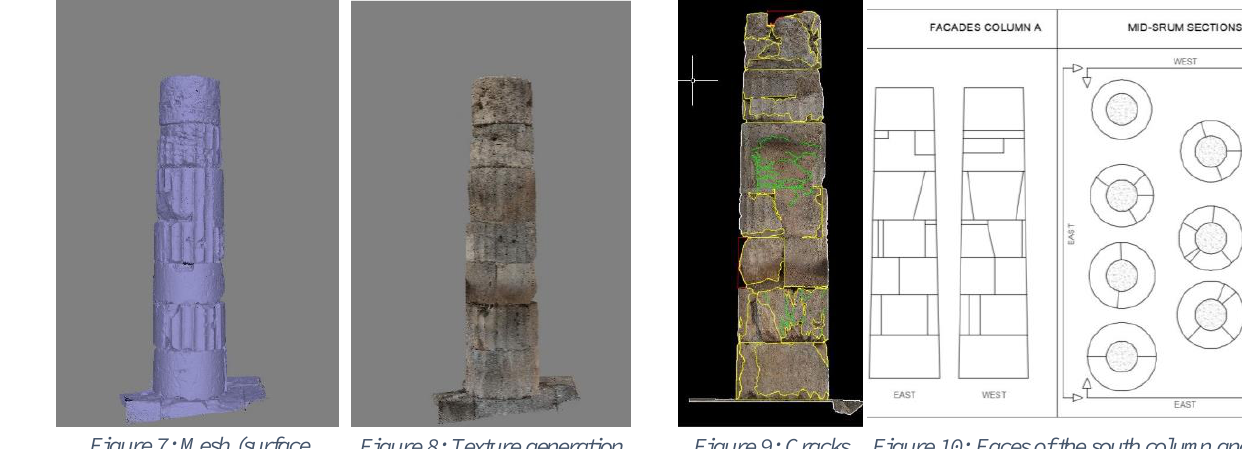
Figure 10: Faces of the south column and and loss of mid-drum sections; plans for assisting materials recording FEM